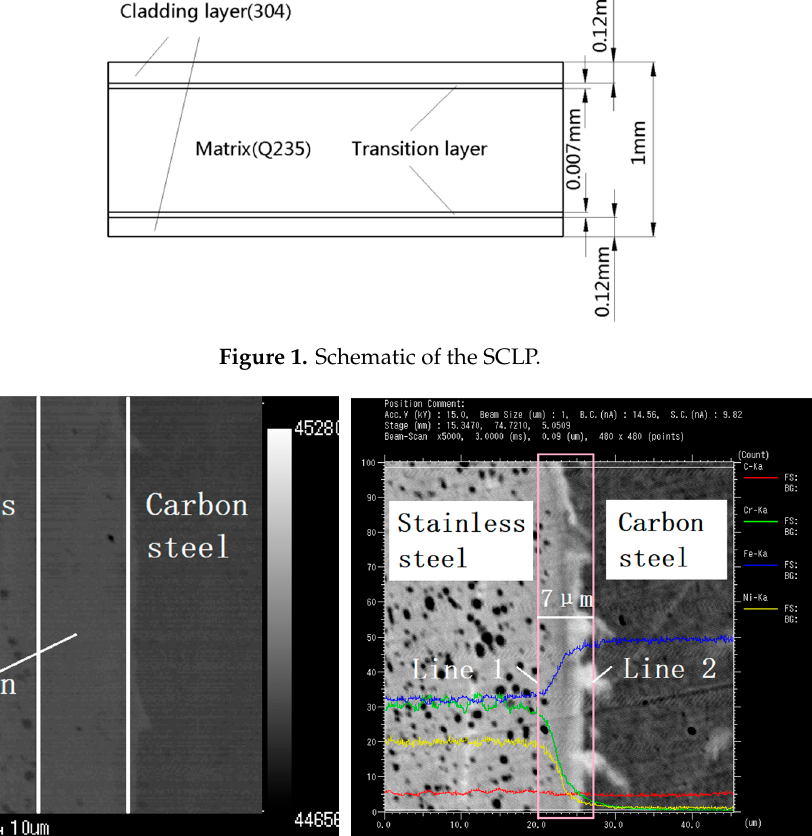
( b ) Figure 4. FEM grid partition profile of the SCLP: ( a ) Grid partition in the XOY plane; ( b ) Grid partition in the Z-axis direction. 2.3. Temperature Gradient Mechanism Based on Definition of Depth of Plastic Zone When the laser beam with a fast scanning speed, small diameter and high energy density irradiates on the SCLP’s surface, the upper surface is heated to a high-temperature state, but the temperature of the lower surface is low. Therefore, a large temperature gradient is generated along the thickness direction. In the thickness direction, in the zone where the maximum of temperature exceeds the recrystallization temperature, because of grain growth, the grain boundary migrates and